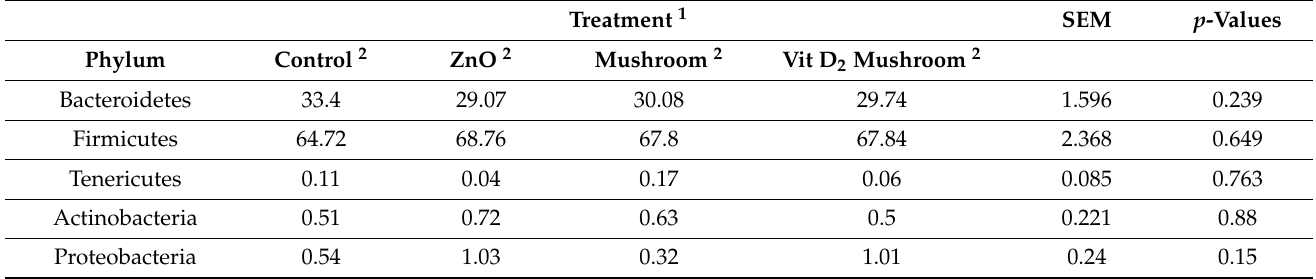
Table 6. The effect of dietary treatment on the % bacterial abundance at phylum level (Least-square means with their standard